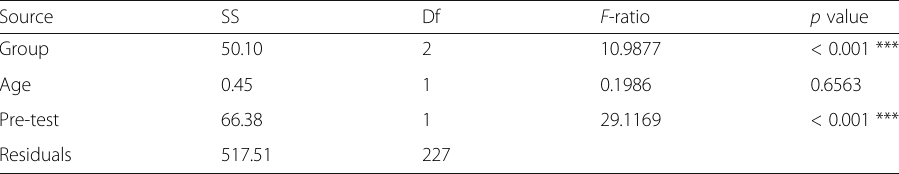
Table 6 Analysis of variance (ANOVA) type II result for immediate test and pre-test Source